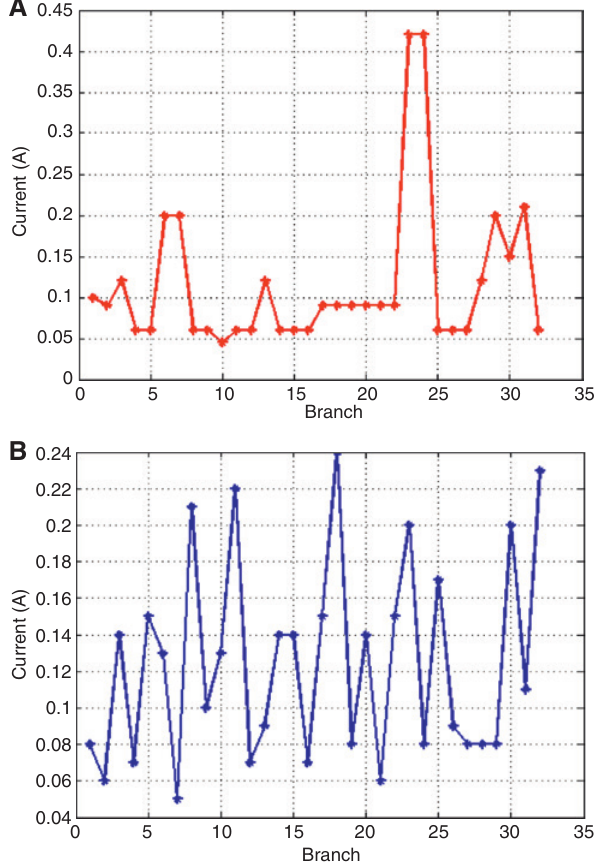
Figure 5: (A) Performance Analysis of the Current Profile Using the B/F Sweep Method. (B) Performance Analysis of the Current Profile Using the Proposed